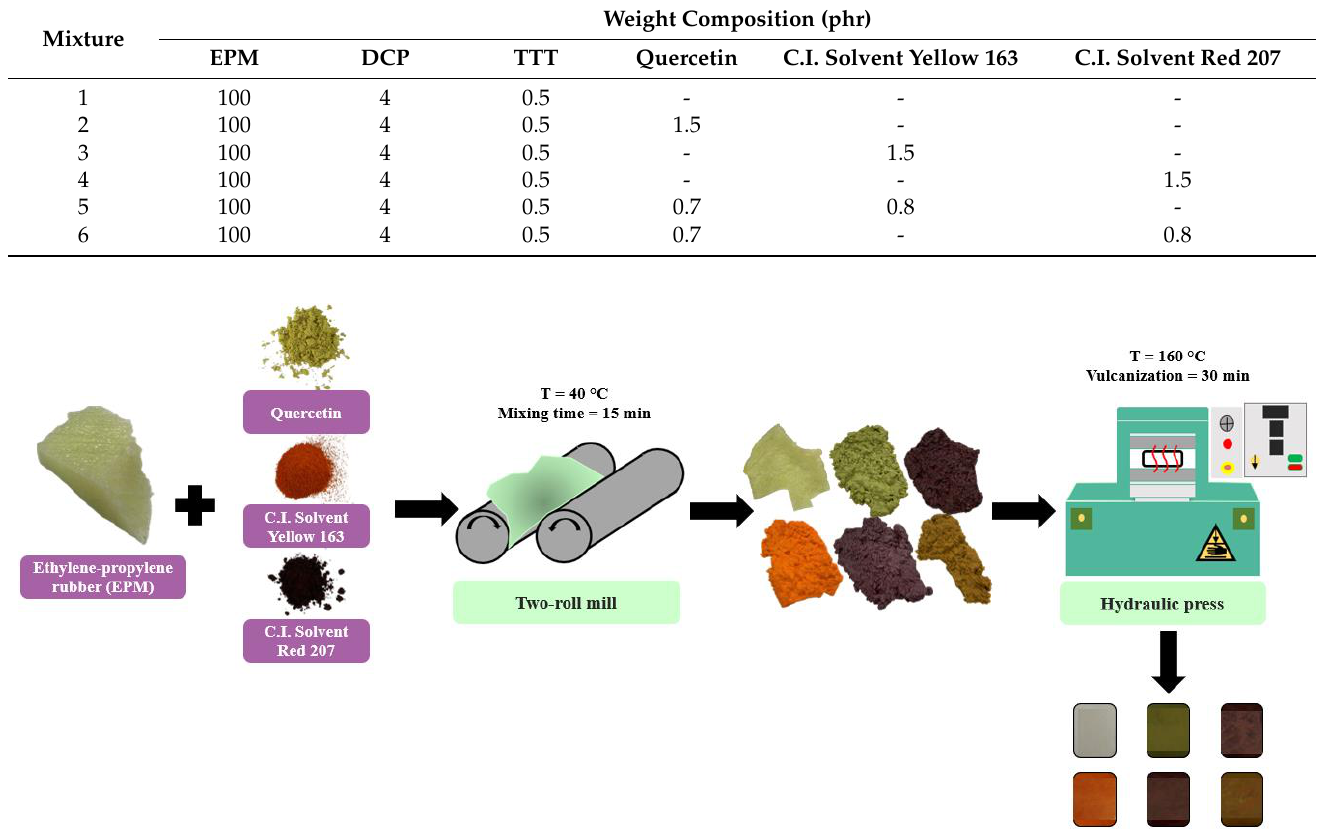
Table 4. Weight composition of ethylene-propylene rubber mixtures with synthetic and natural colorants.